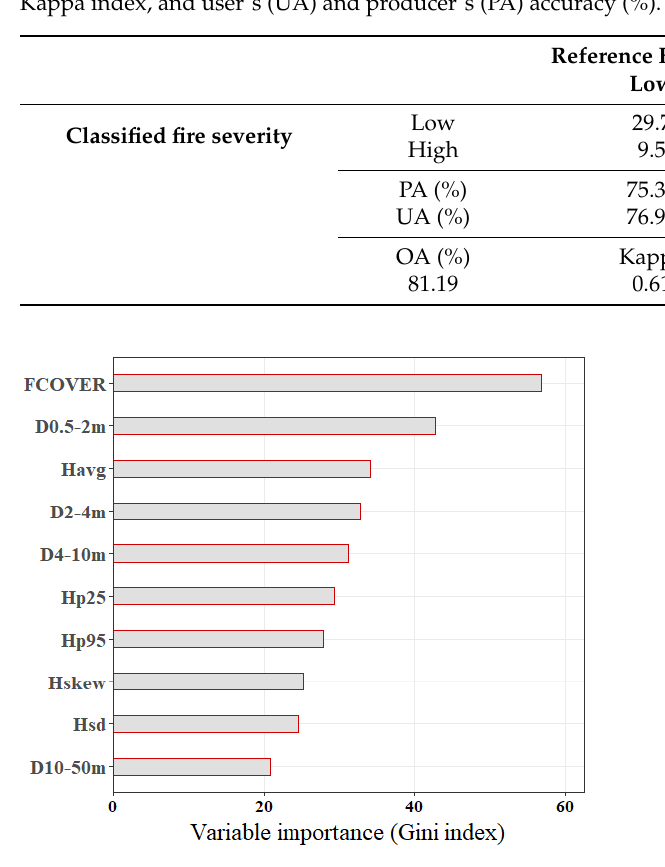
Figure 6. Variable importance (Gini index) of the pre-fire LiDAR metrics in the Random Forest (RF) classification algorithm of fire severity.